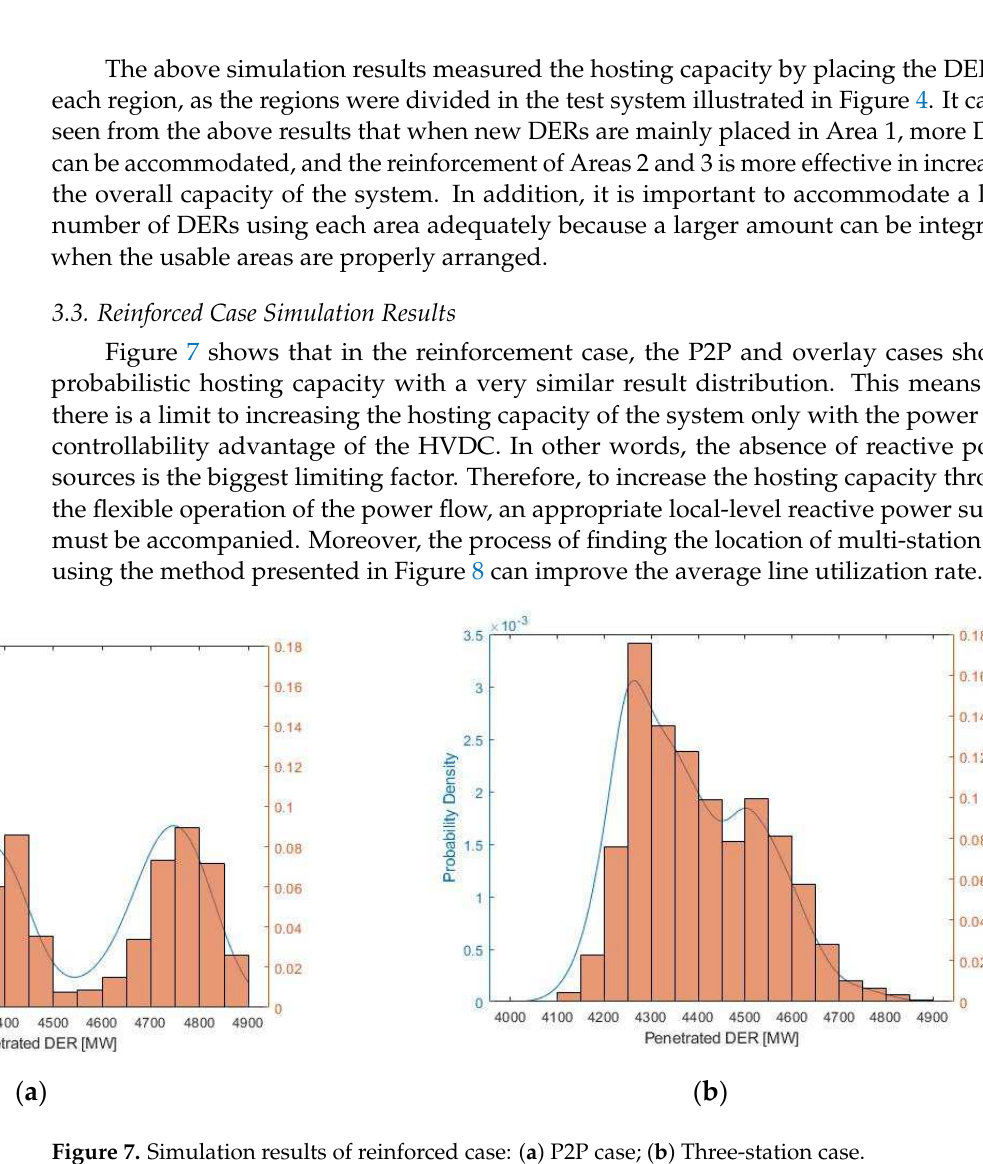
Figure 6. Results of simulations of intensive input in each region: ( a ) Area 1 case; ( b ) Area 2 case; ( c ) Area 3 case.